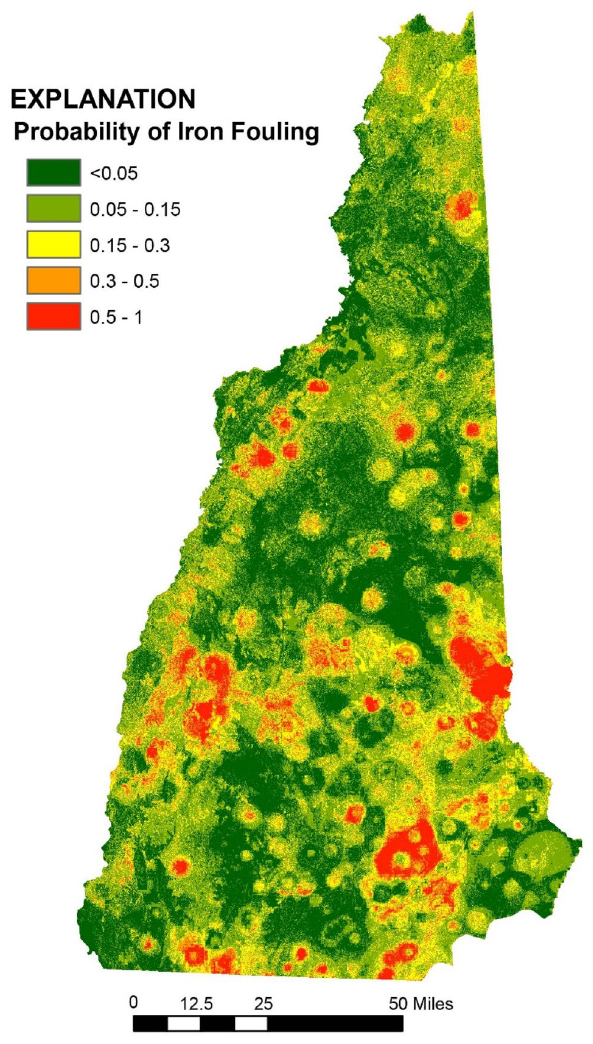
Fig. 4 Probability of iron fouling occurring at any location across NH if rock quarried from that location is used as fill and comes into contact with drainage